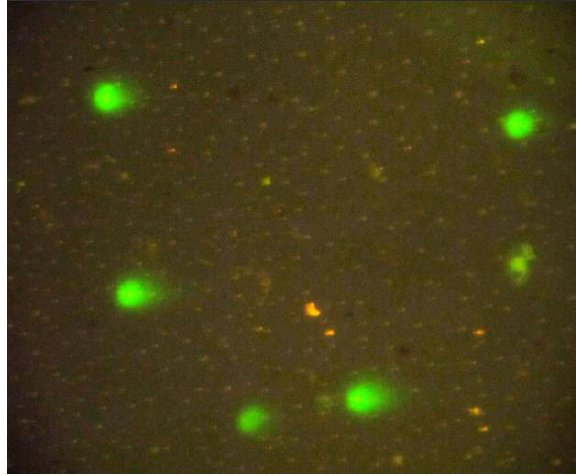
Figure 9. Effect of Nigella sativa seeds silver Nanoparticles by two doses and Nigella sativa extract on score mean comet % of blood in H rats.Values are expressed as mean±SE (n= 8). Various capital letters denote significant differences P<0.05 between periods. Various small letters denote significant differences P<0.05 between groups. Control